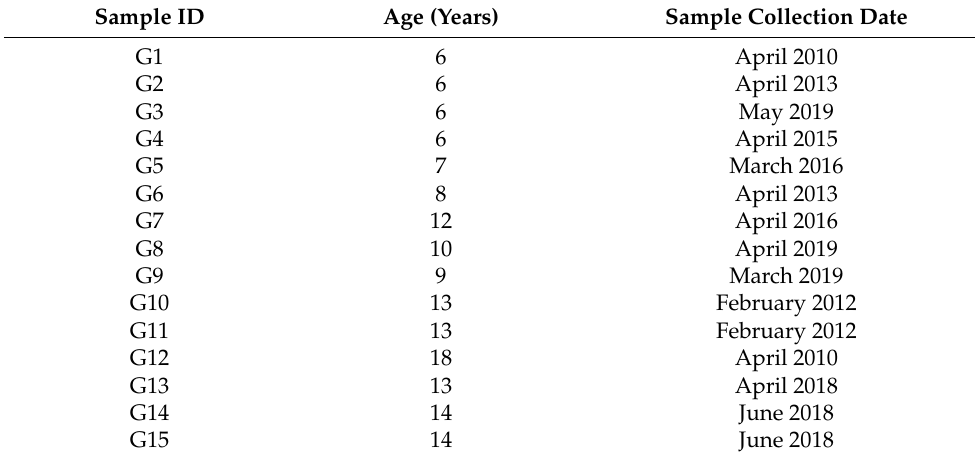
Table 1. Giant panda seminal plasma samples